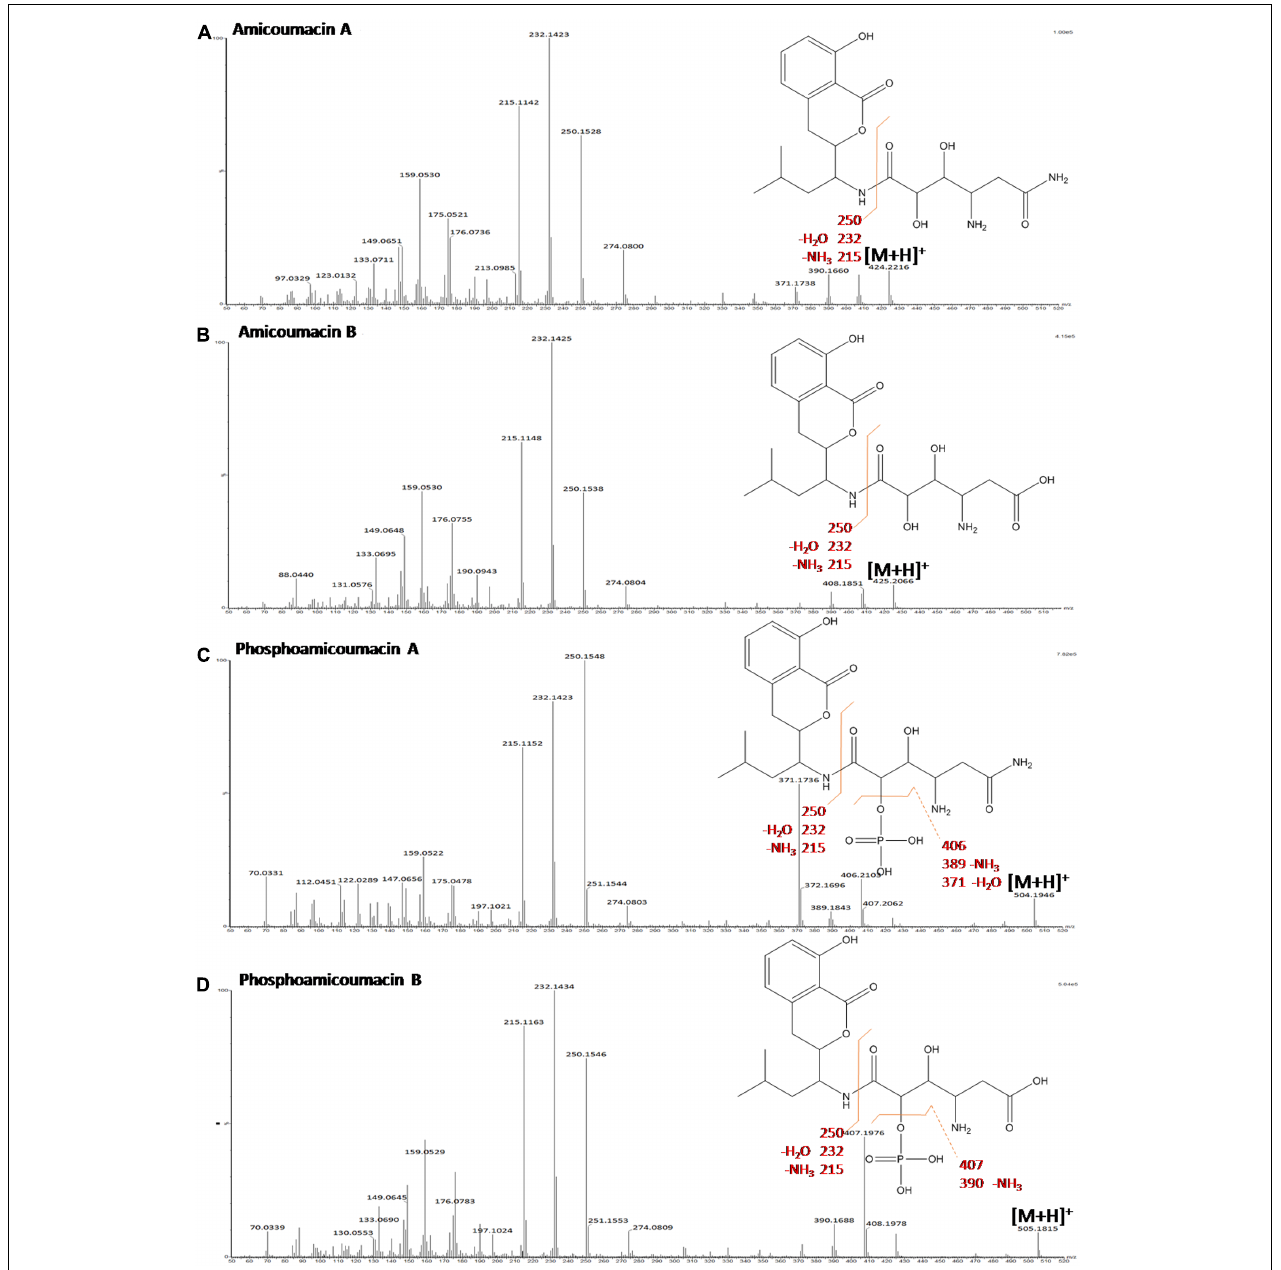
FIGURE 4 | Mass fragmentation patterns obtained by CID of the main abundant forms of amicoumacins: (A) amicoumacin A, (B) amicoumacin B, (C) phosphoamicoumacin A, and (D) phosphoamicoumacin B of B. pumilus 35R COPS CSF. The spectra were produced using a SYNAPT-G2-Si mass spectrometer (Waters) operating in data-dependent